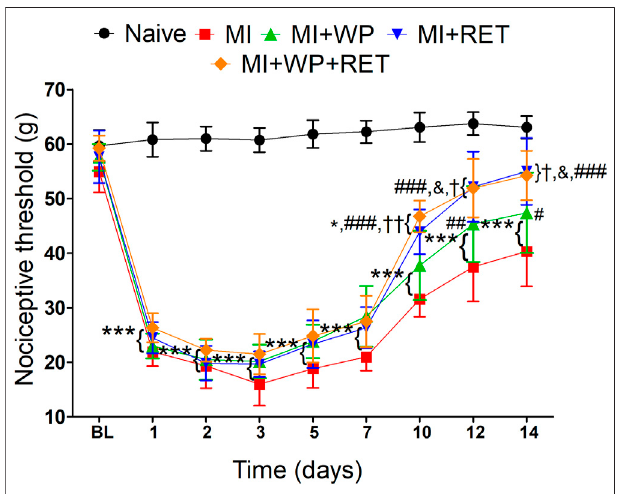
FIGURE 3 | Effect of the resistance exercise training and whey protein supplementation on the muscle pain induced by injury. First, the baseline (BL) nociceptive threshold of each animal was measured and then the muscle injury (MI) was induced. After that, rats were subjected to resistance exercise training (RET) and/or whey protein (WP) supplementation and new measurement of the nociceptive threshold was performed after the 1st and 2nd days and every 2 days until the 14th day. Data are expressed as the mean ± S.E.M. of six animals per group. * p < 0.05 and *** p < 0.001 indicate statisticalsigni fi cancecomparedtothenaïvegroup;* p < 0.05,** p < 0.01,and *** p < 0.001 indicate statistical signi fi cance compared to the MI group; & p < 0.05 indicates statistical signi fi cance between MI + RET and MI + WP groups; and * p < 0.05and ** p < 0.01indicate statistical signi fi cance between MI+WP +RETand MI+WPgroups.Two-wayANOVA wasfollowedbytheBonferroni post hoc